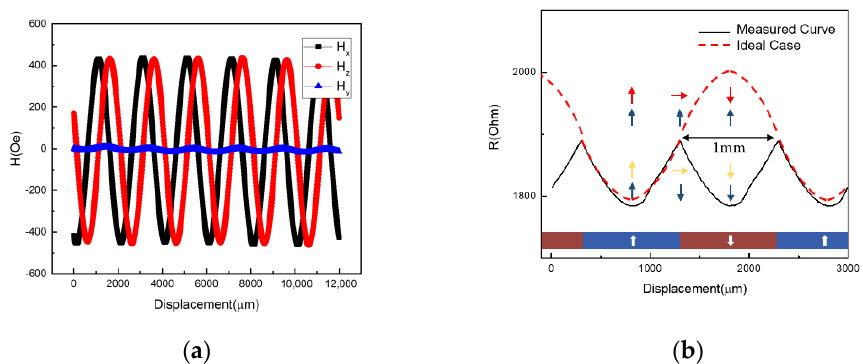
Figure 4. ( a ) The field profile of the INC line measured by 3-axis Hall sensor. ( b ) The output signal for the MTJ with RL switched during the scale measurement.